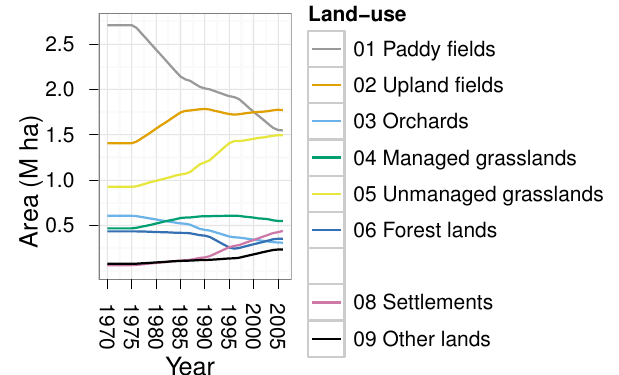
Figure 3. Temporal changes in the area of different land-use types in agricultural land of Japan used in the simulation during 1970–